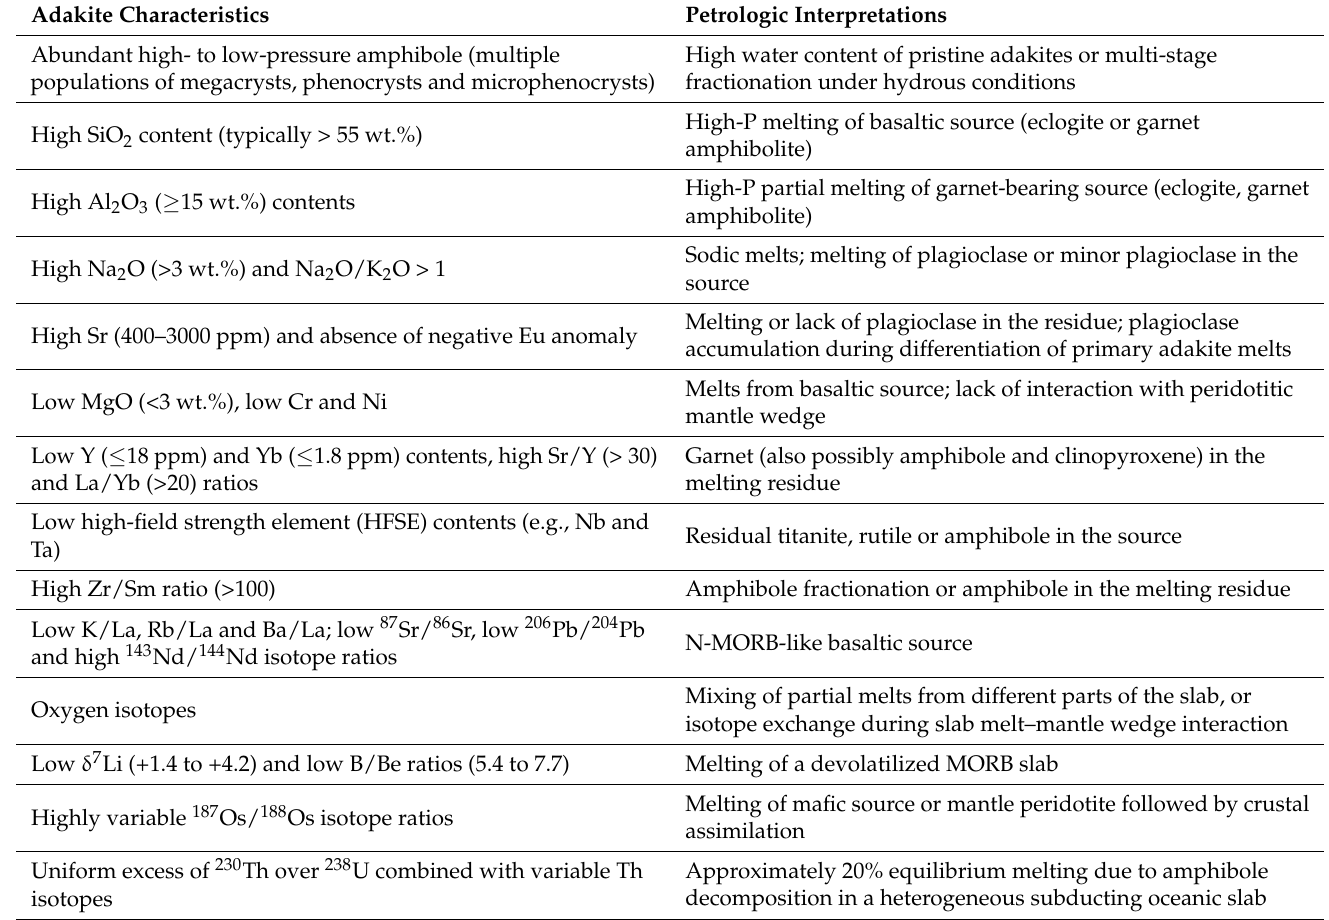
Table 1. Petrologic and geochemical characteristics of adakites [37–39,49–53,60,80,81,91–115].